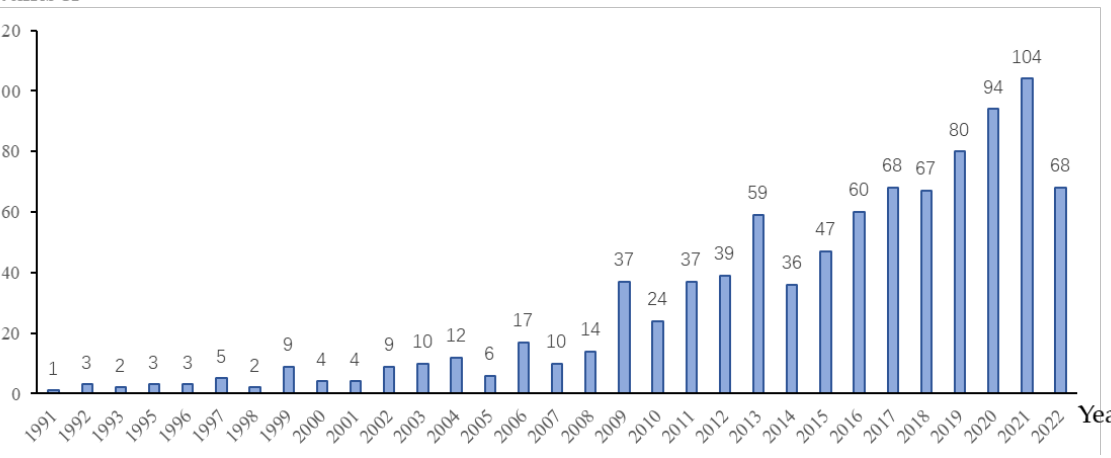
Figure 2. Number of RCHSCC articles issued from 1991 – 2022.